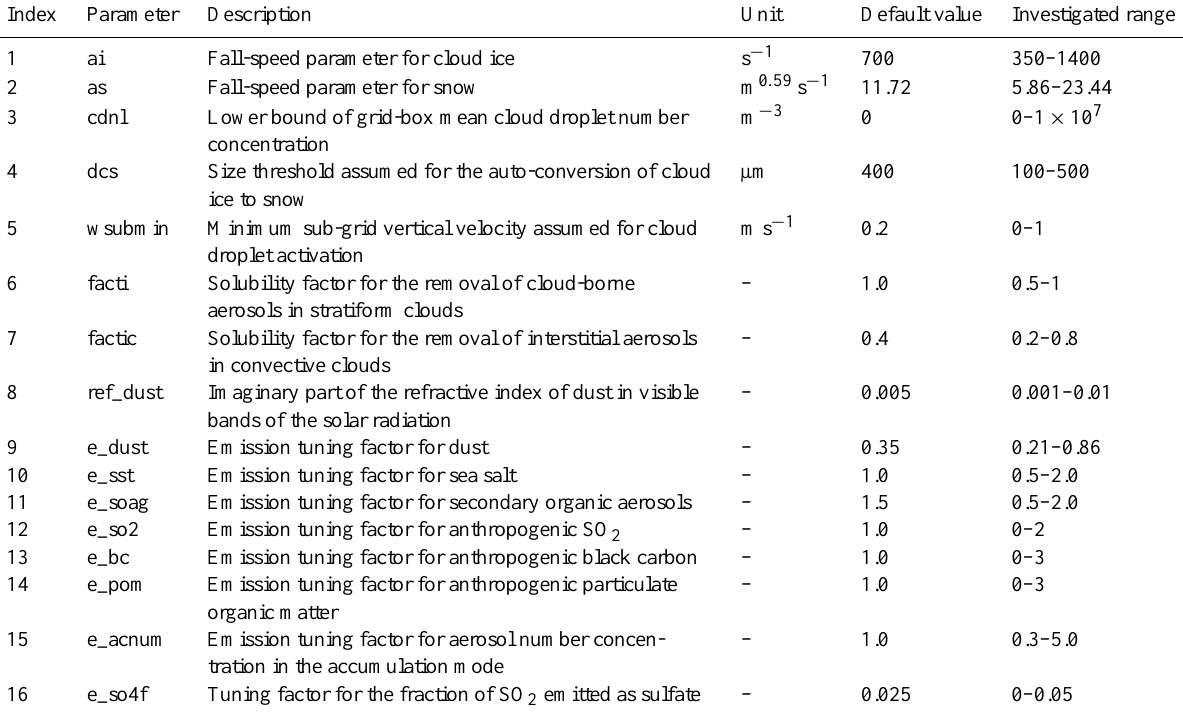
Table 2. Empirical parameters in the cloud microphysics and aerosol life cycle parameterizations in CAM5 that are perturbed in the sensitivity analysis described in Sect. 4. Adapted from Table 1 in Zhao et al.